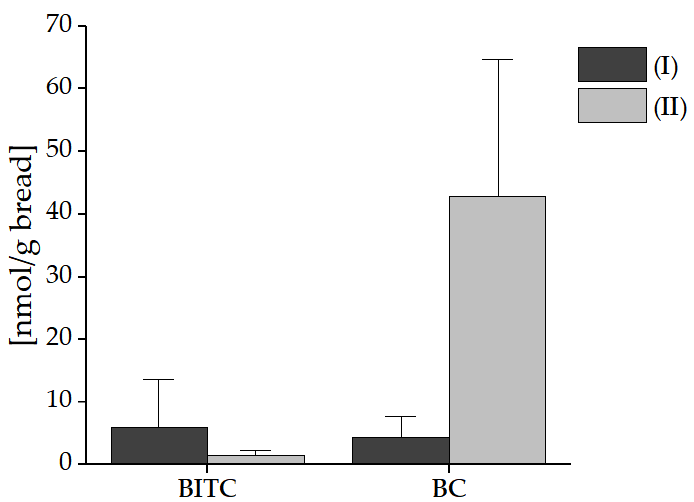
Figure 7. Formed benzyl glucosinolate breakdown products BITC and BC in bread with freeze-dried nasturtium (application No. I) and garden cress microgreens (application No. II) mixed into the dough. The breads were prepared in triplicate. Abbreviations: BITC: benzyl isothiocyanate, BC: benzyl cyanide.